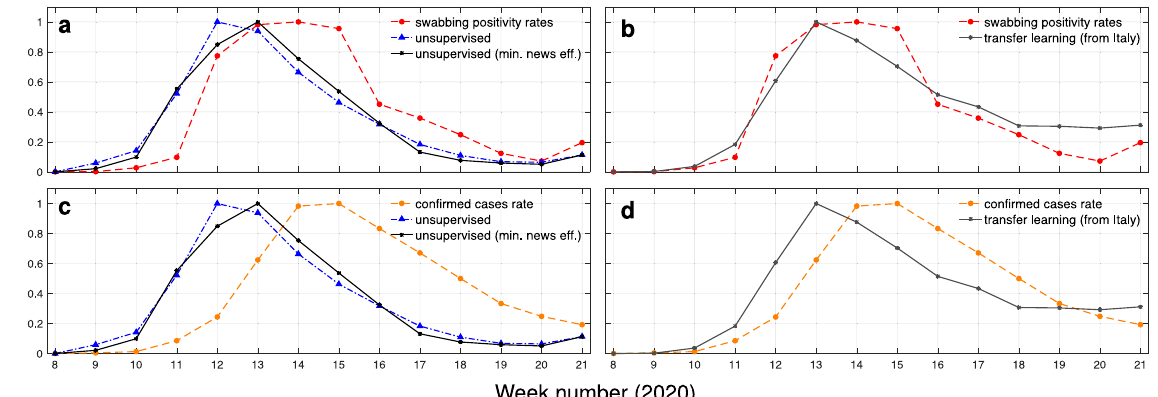
Fig. 5 Comparison of weekly online search-based signals for COVID-19 to different clinical endpoints for England. a Estimates from the unsupervised models with or without minimising news media effects are compared to COVID-19 positivity rates obtained through a swabbing test scheme operated by the RCGP. b Estimates for COVID-19 obtained via transfer learning (source model of con fi rmed cases is based on data from Italy) are compared to COVID-19 positivity rates obtained through a swabbing test scheme operated by the RCGP. c Estimates from the unsupervised models with or without minimising news media effects are compared to con fi rmed cases rates as reported by PHE. d Estimates for COVID-19 obtained via transfer learning (source model of con fi rmed cases is based on data from Italy) are compared to con fi rmed cases rates as reported by